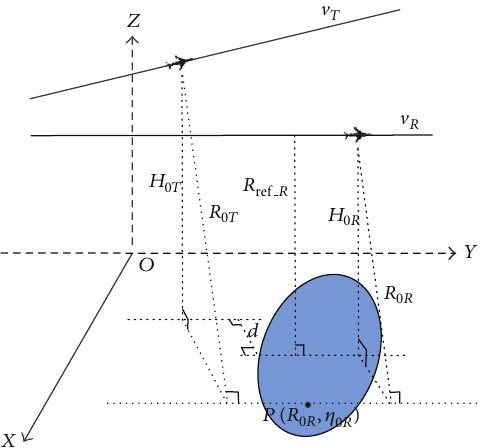
Figure 2: Geometric transformation